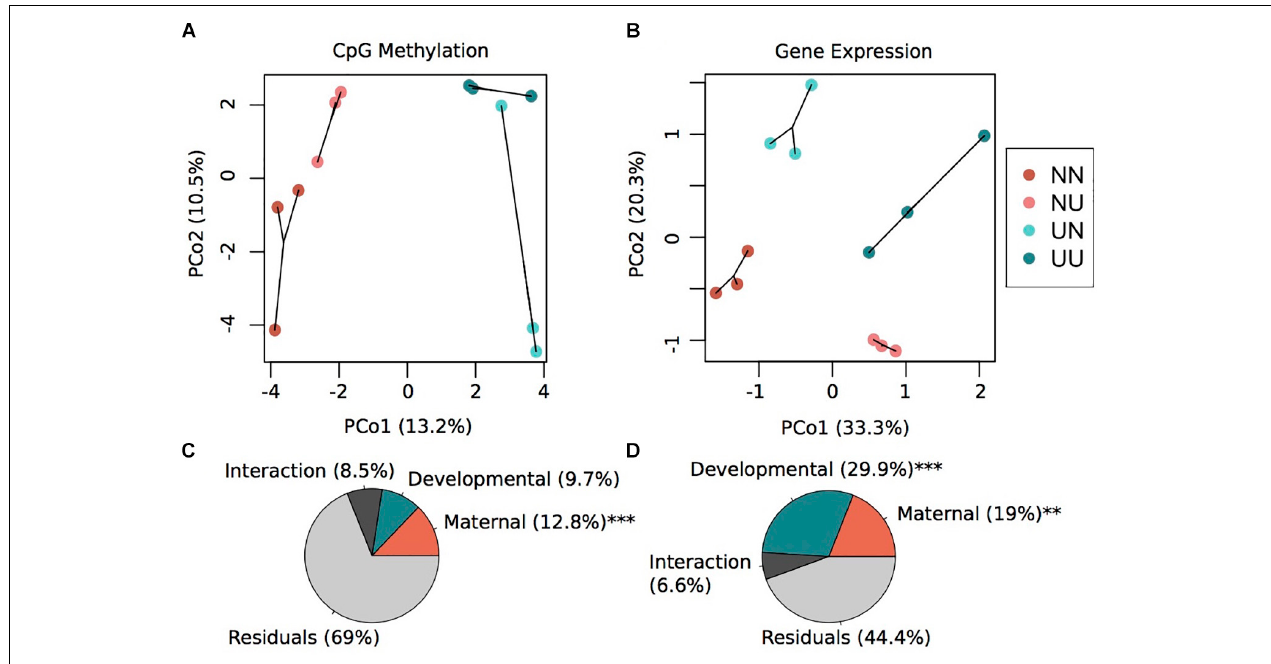
FIGURE 1 | Environmental conditions induce changes in gene expression and DNA methylation. Principal coordinate analysis of CpG methylation (A) and gene expression (B) . Variance explained by each principal coordinate is specified in the axes labels. Sample labels denote the maternal environment first and the developmental environment second. N, Non-Upwelling, U, Upwelling. Percentage of variation in CpG methylation (C) and gene expression (D) explained by fixed factors of maternal or developmental rearing environment using a permutational multivariate ANOVA. *** p < 0.001 and ** p <